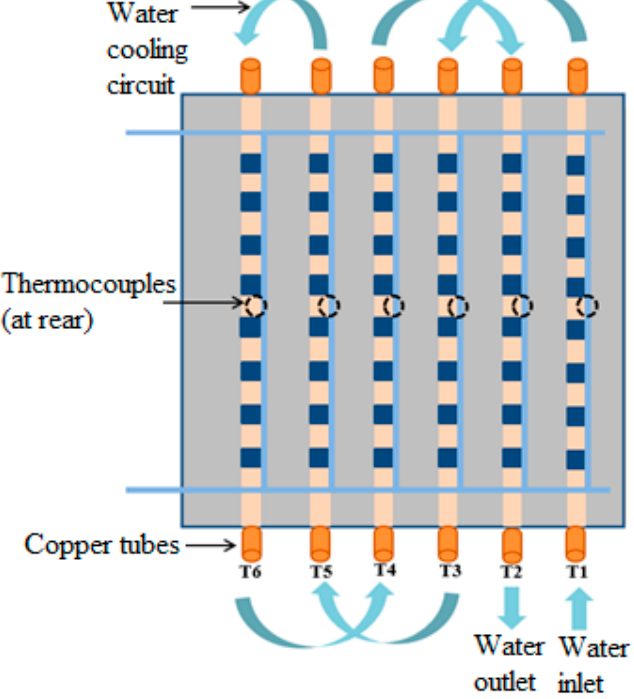
Figure 4. Water flow circuit for cooling the tubes behind the WICPV system.